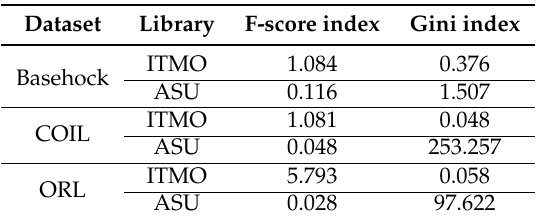
Table 3. Comparison of ASU feature selection library and ITMO FS library computational time in